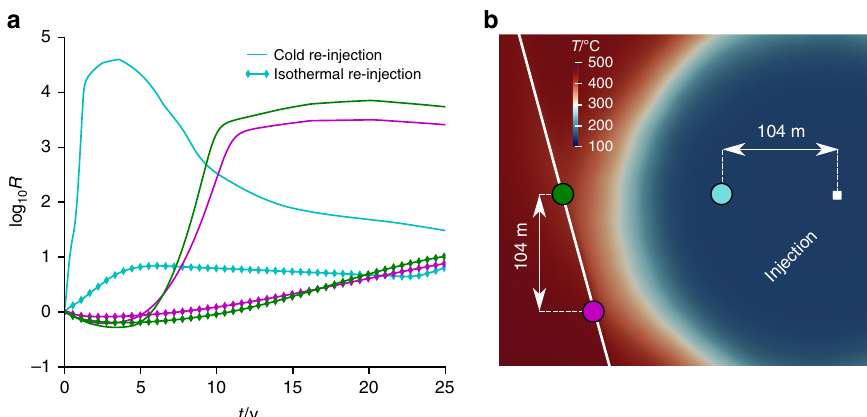
Fig. 6 Rate of seismic production. The rate of seismicity production is computed at different locations in the main fault and in the fractured rock (curve colours in a refers to points which are indicated in the model in b ), for isothermal and cold water re-injection. Injecting cold fl uids generates signi fi cantly higher induced seismicity than injecting fl uids in thermal equilibrium with the